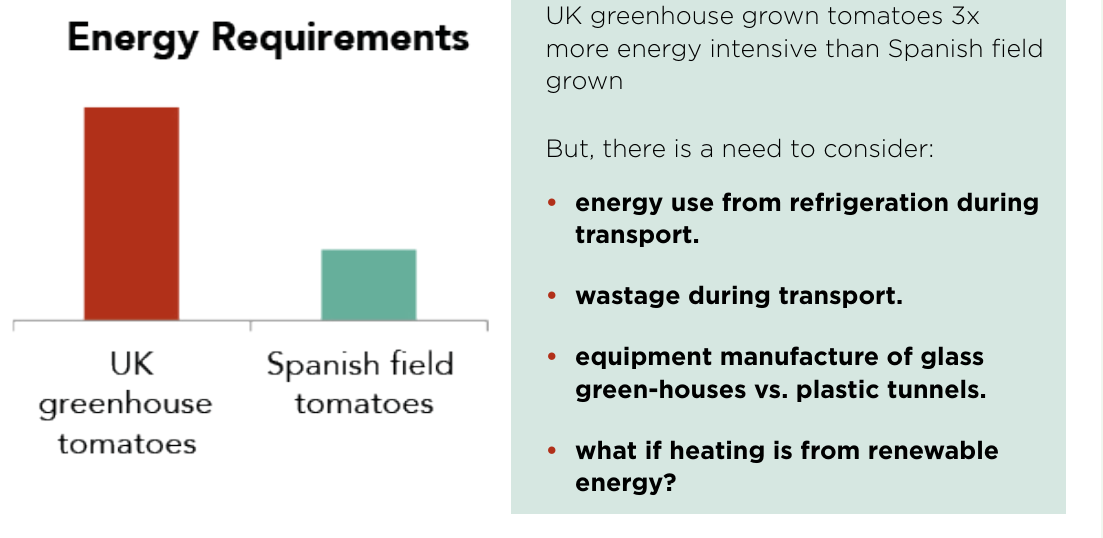
Figure 12: Comparison of energy use to produce tomatoes – UK greenhouse vs. Spanish field grown. Source : FCRN.